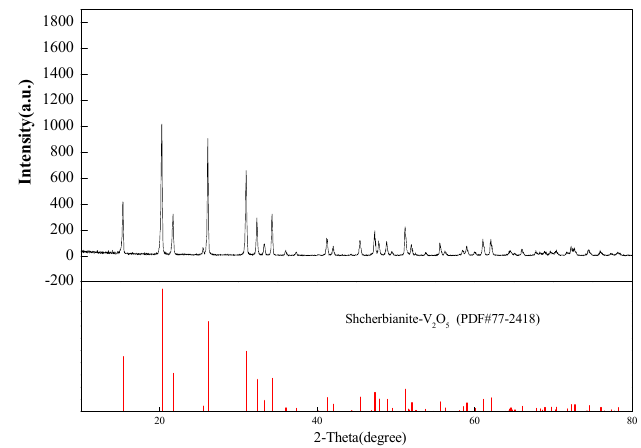
Figure 13. XRD patterns of the product obtained after calcination in argon.